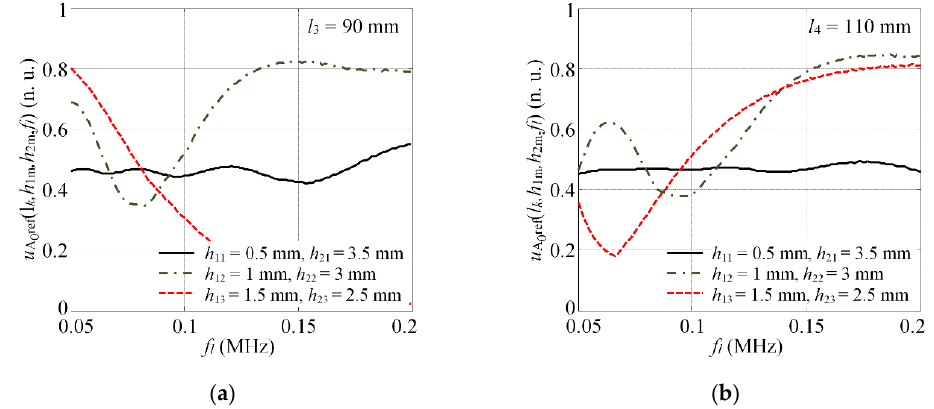
Figure 7. Magnitude variation of transmitted A 0 mode versus frequency at different defect depths in case the length of defect is equal to x 3 = 90 mm ( a ) and x 4 = 110 mm ( b ).